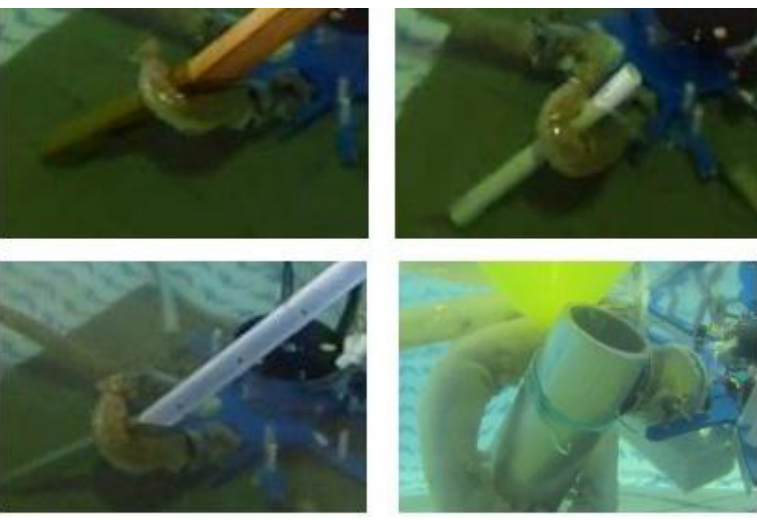
Figure 11. Grasping of different objects (from top left): wooden bar (object 1), thin polymeric tube (object 2), thick polymeric tube (object 3) and aluminum tube (object